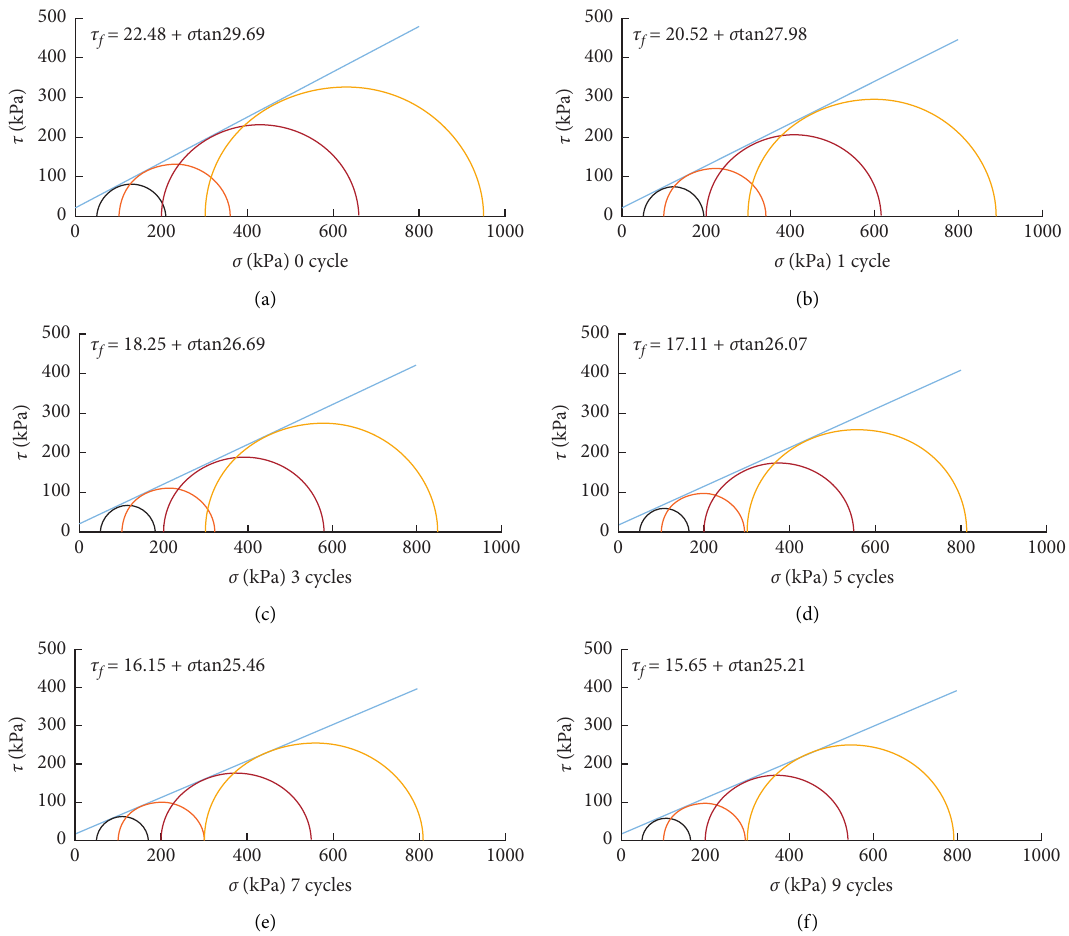
Figure 15: Molar stress circles and Coulombic strength lines of red clay failure under different wet and dry cycles ( τ